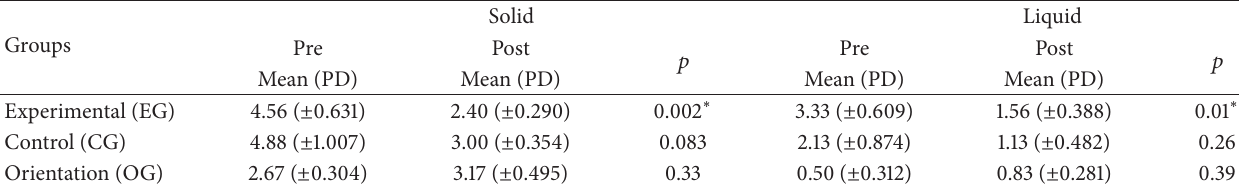
Table 2: Correlation between the periods before and after clinical evaluation of